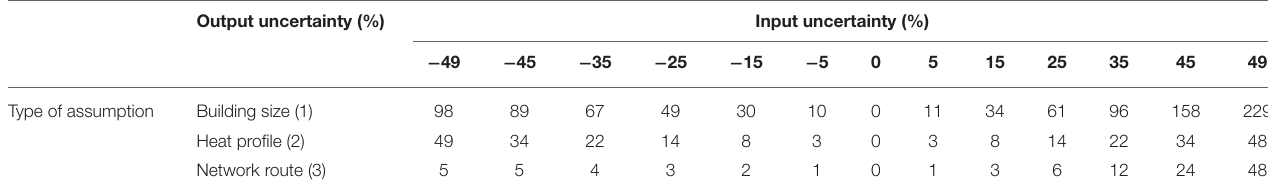
TABLE 3 | Input and output uncertainty for the different Monte Carlo